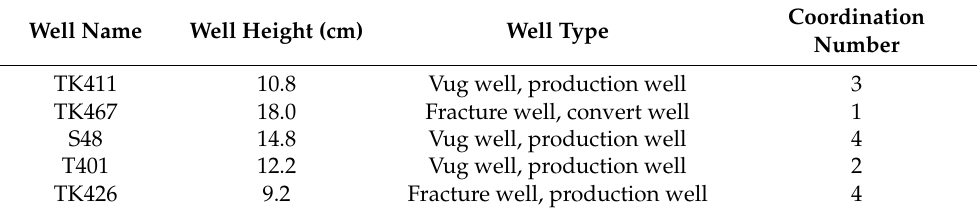
Table 4. Well parameters of three-dimensional visualized fracture–vuggy